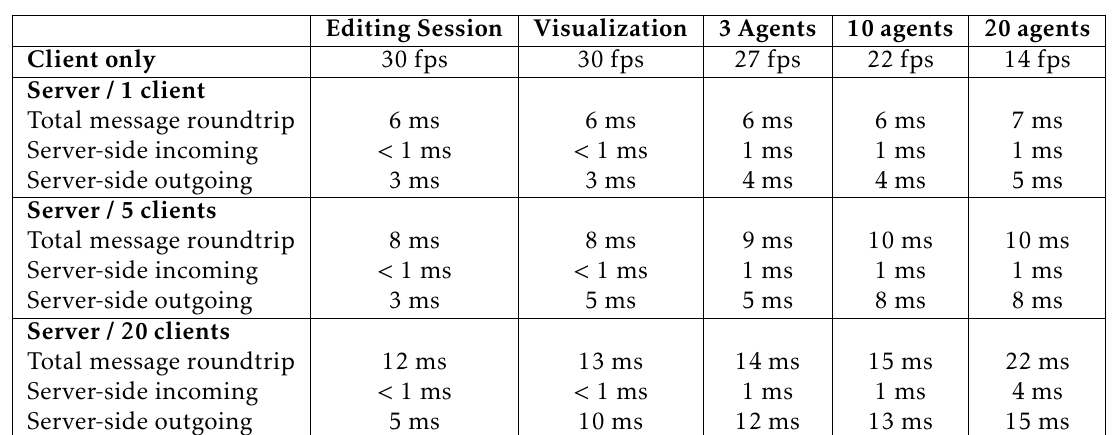
Table 1. Render frame rate and message processing times for increasing scene